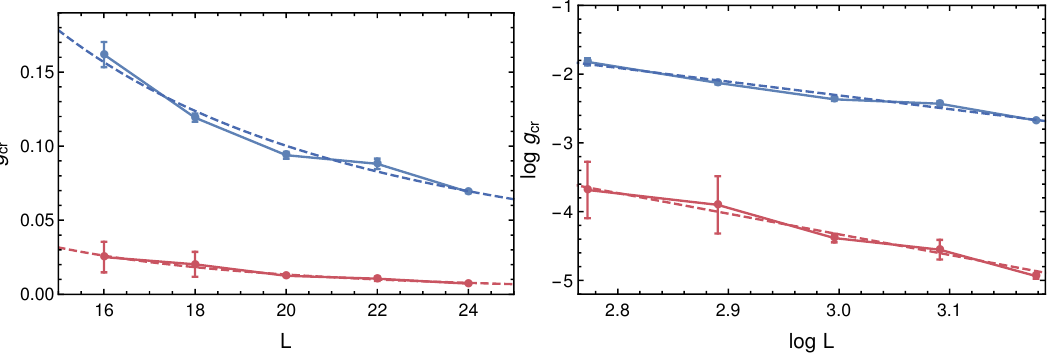
Figure 9: The crossover scale as a function of the volume for the current (blue markers) and NNNI perturbations (red markers) on normal (left) and log-log scale (right) as obtained in the gapless phase ( ∆ = 0.2). Dashed lines correspond to the fitted AL − 3 (red) and BL − 2 (blue)